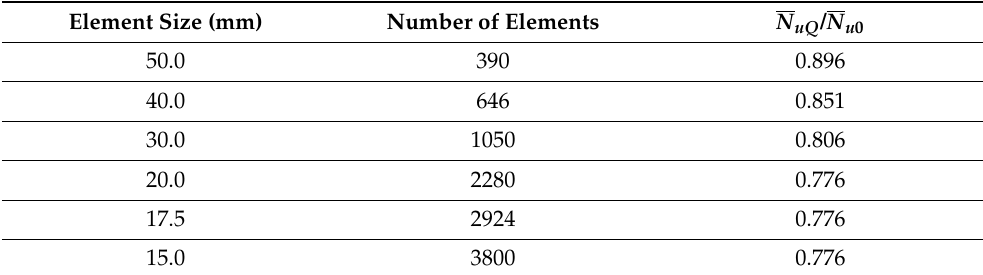
Table 5. Mesh convergence test for the stiffened plate with semi-circular opening and width of 170 mm.